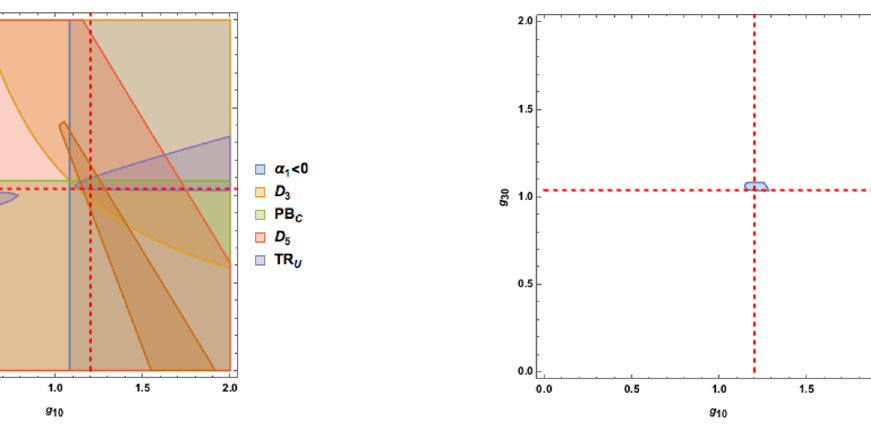
Figure 8. The intersection of the red lines indicates the open string